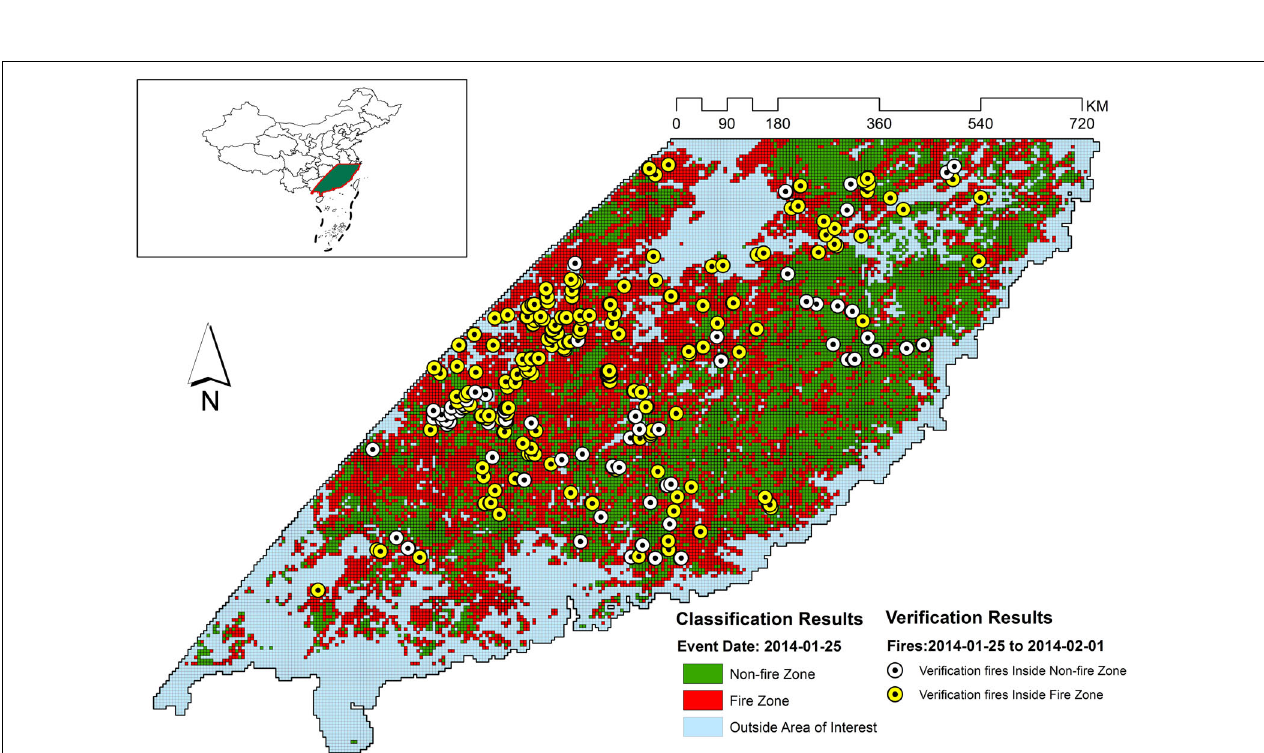
FIGURE 8 | Classification and verification results for